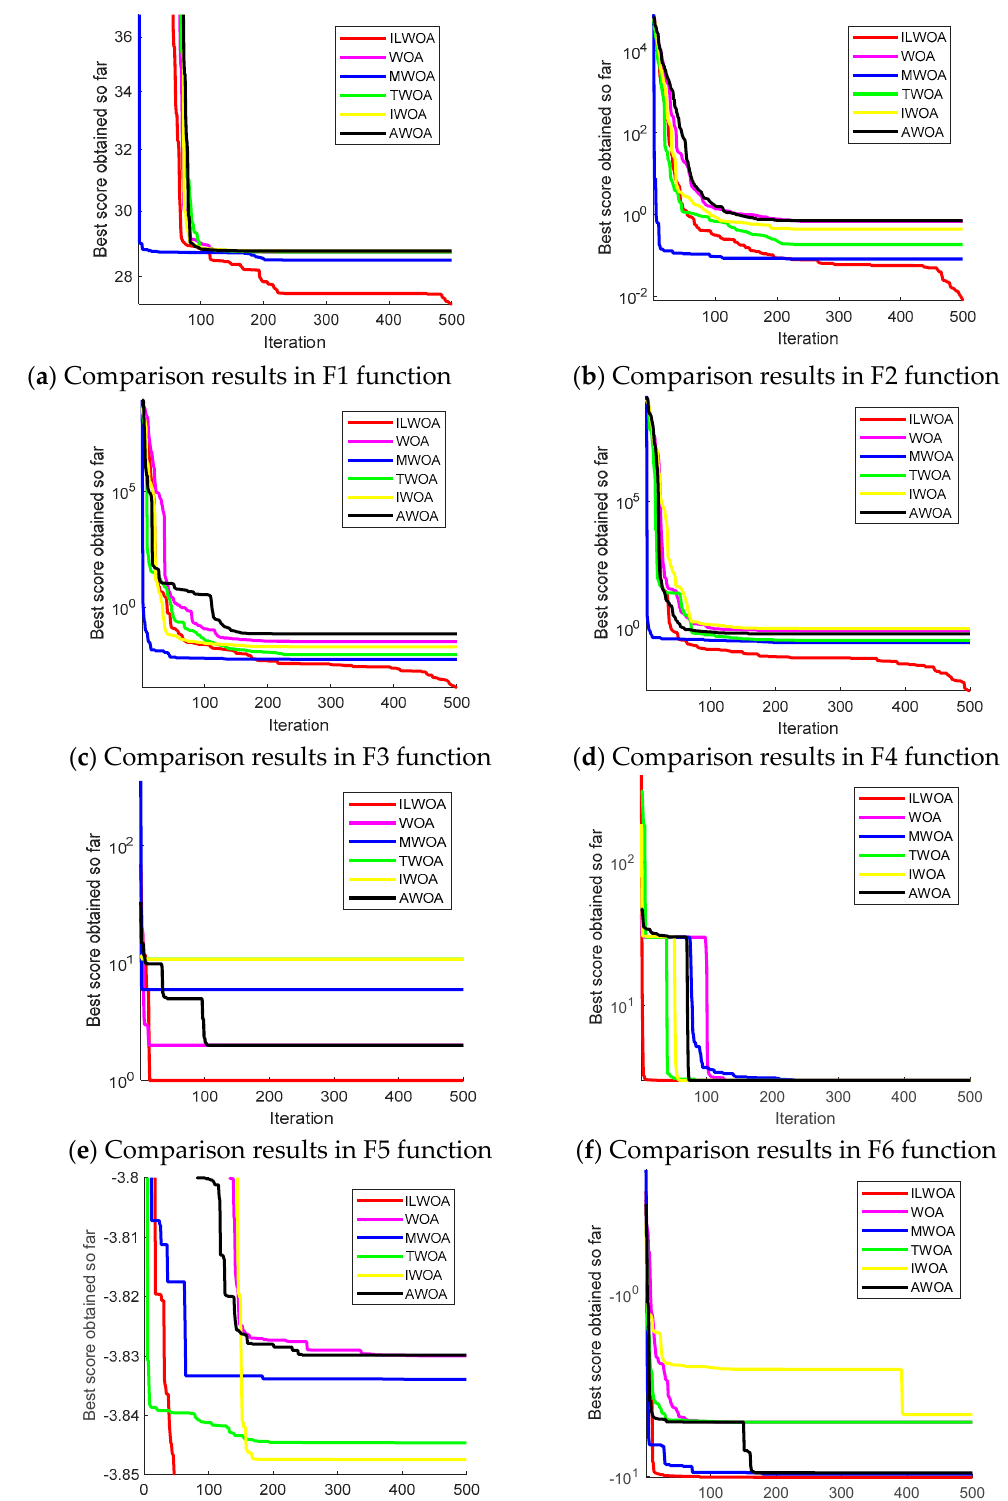
Figure 8. Curve chart based on eight test